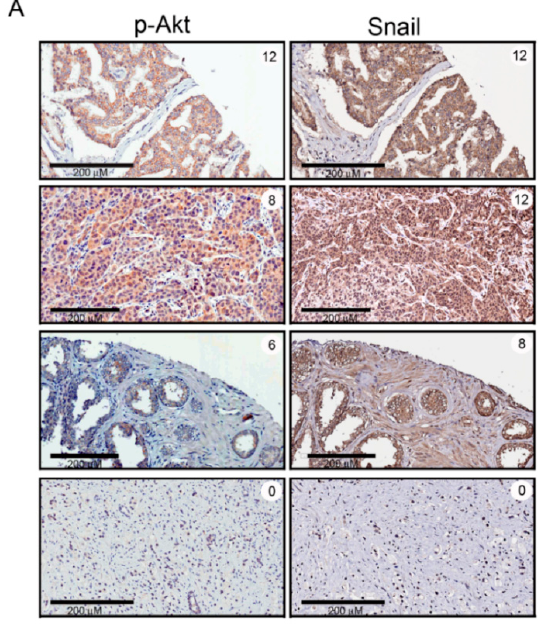
Figure 2. Cont. Figure 2.